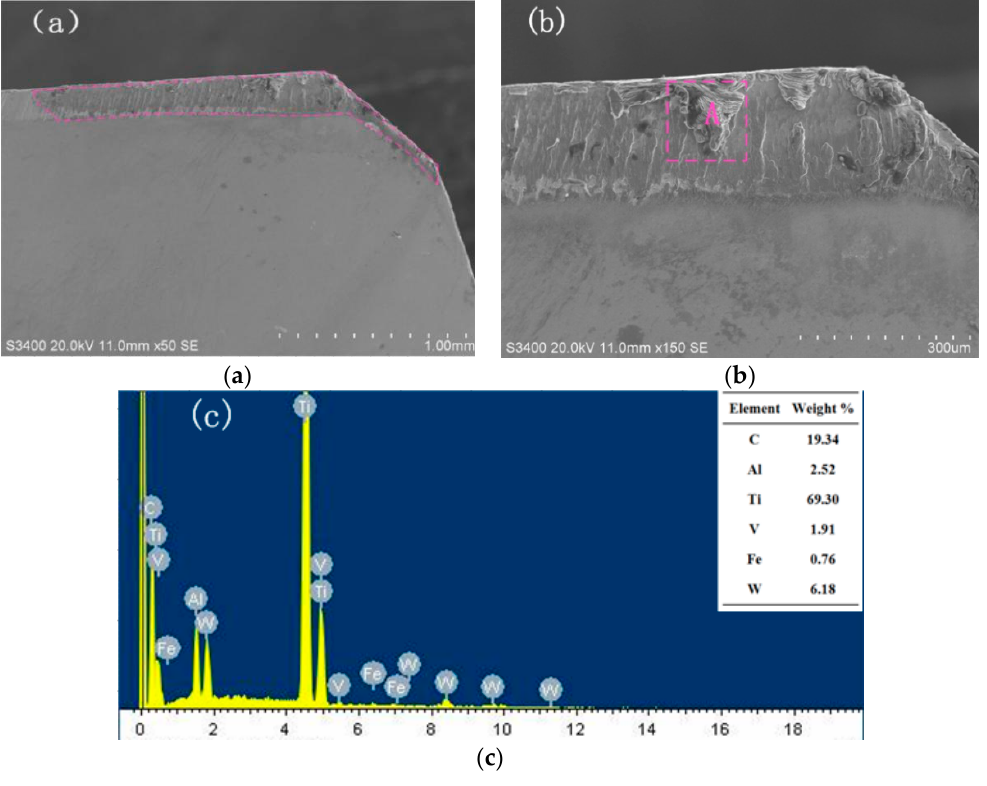
Figure 6. SEM and EDX of wear at the rake face of non-textured tool (v = 90.4 m/min, a p = 0.4 mm). ( a ) Wear morphology; ( b ) Enlarged morphology; ( c ) EDX of zone A. ( a ) Wear morphology; ( b ) Enlarged morphology; ( c ) EDX of zone